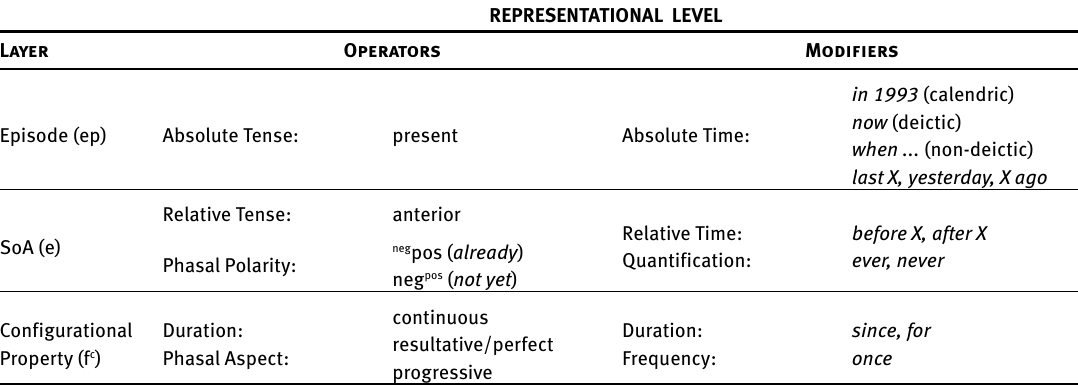
Table 1. Overview of operators, modifiers and discourse functions relevant in a discussion of the English PrP in FDG REPRESENTATIONAL